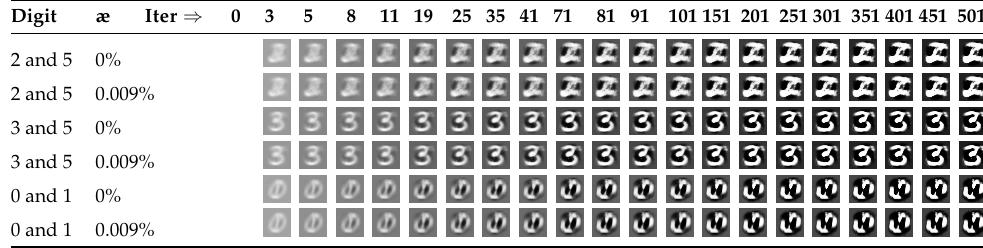
Table 6. Non-intuitive MBVCR observations with RAN model of MNIST